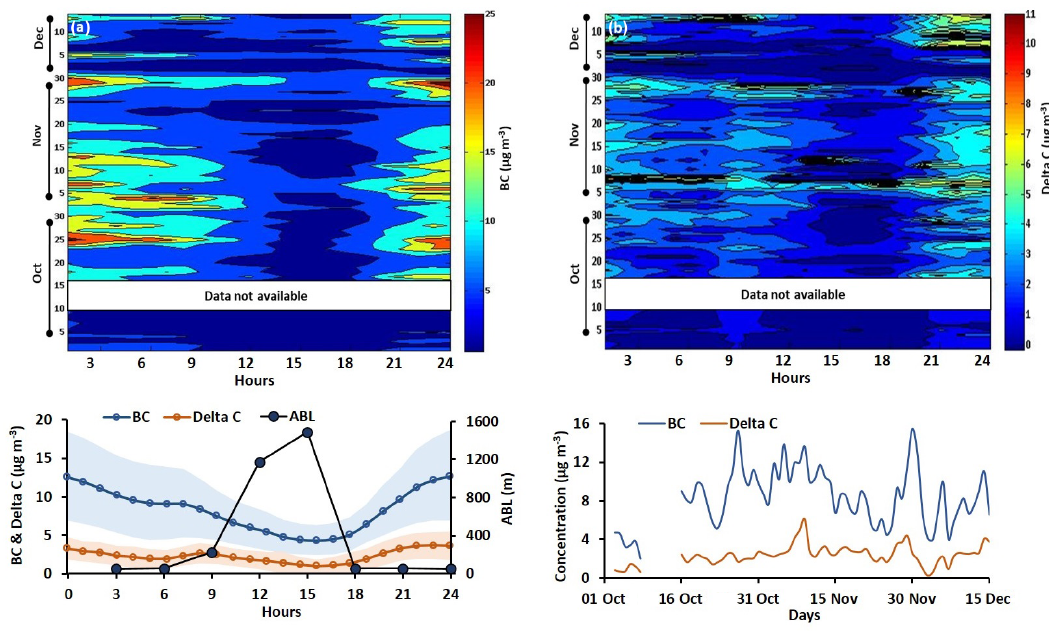
Figure 4. Variation in BC, Delta-C, and ABL during the entire monitoring